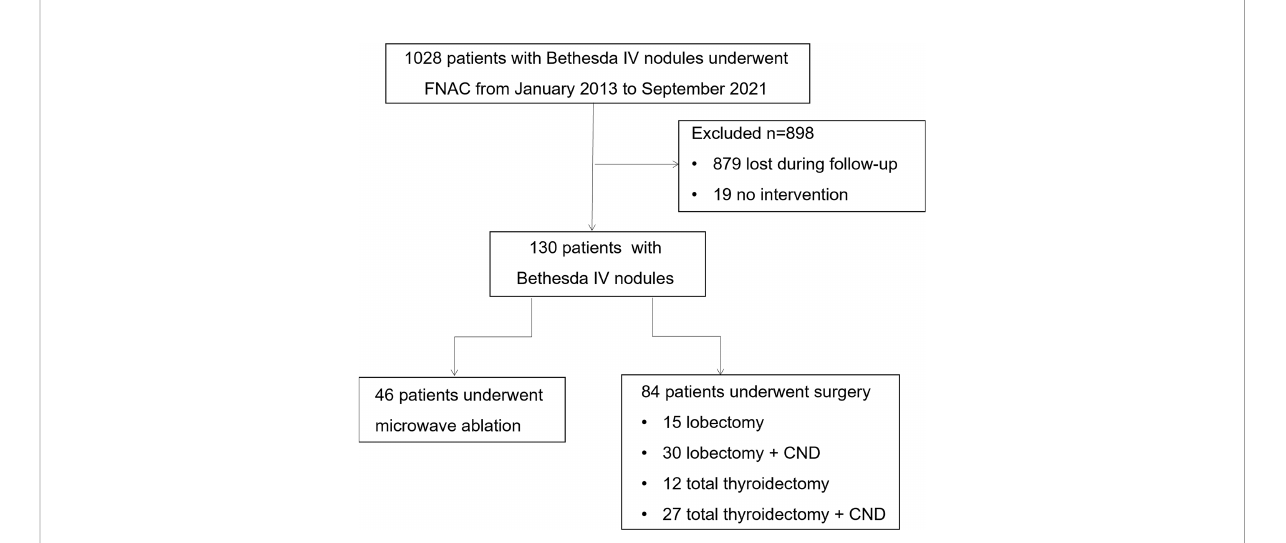
FIGURE 1 Flowchart summarizing the patient inclusion process. FNAC, fi ne-needle aspiration cytology; CND, central lymph node